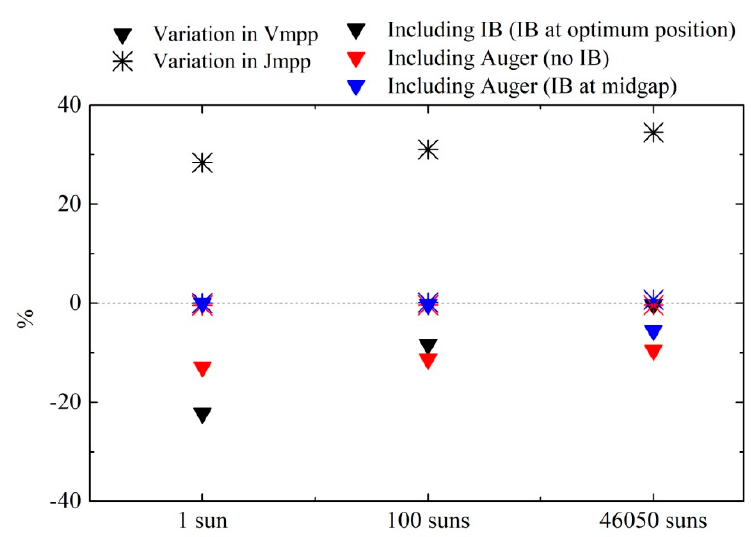
Figure 5. Relative variation of the voltage and current density at the maximum power point produced when an IB (black symbols) and Auger recombination are included. The effect of including Auger recombination is evaluated when there is no IB (red symbols) and when there is an IB at the middle of the bandgap (blue symbols).